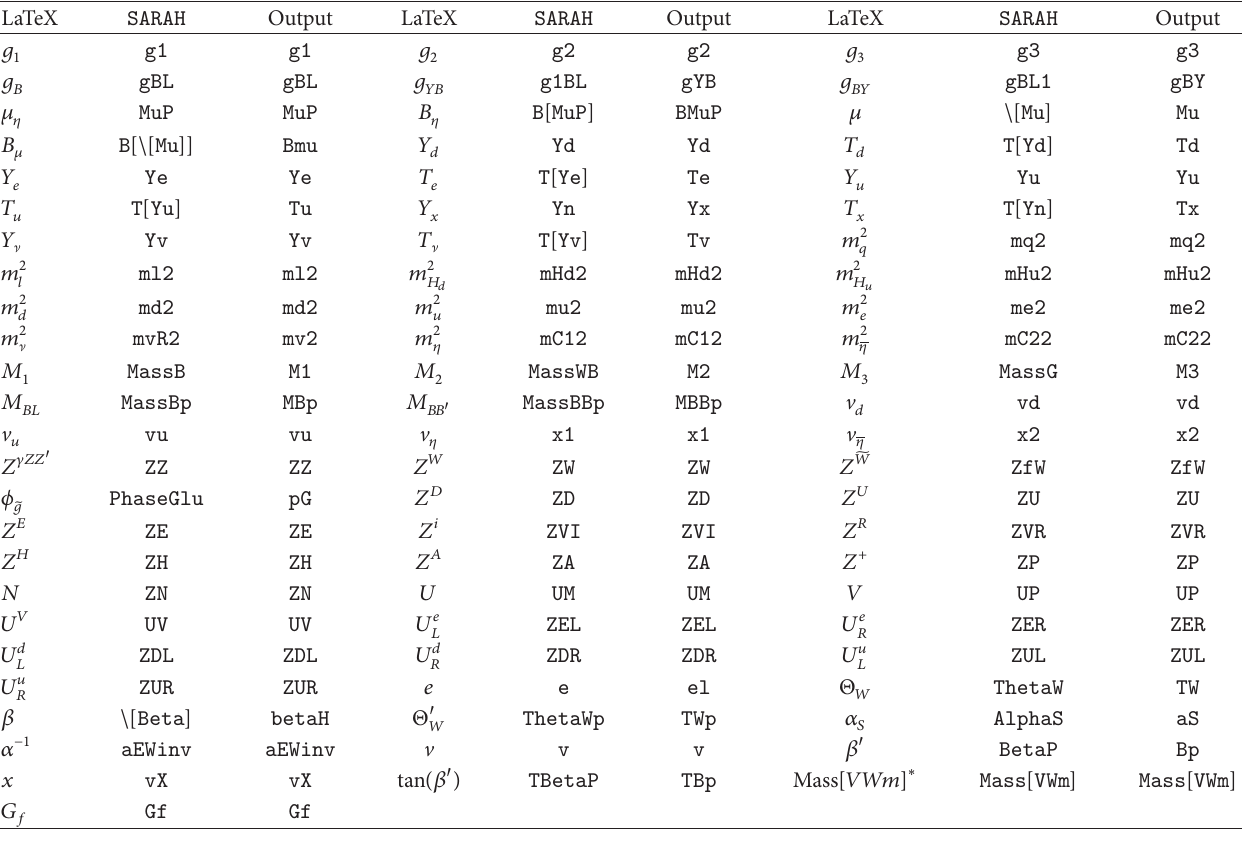
Table 6: All parameters in the B-L- SSM with their names used internally by SARAH as well as the names for the LaTeX and other outputs. LaTeX SARAH Output LaTeX SARAH Output LaTeX